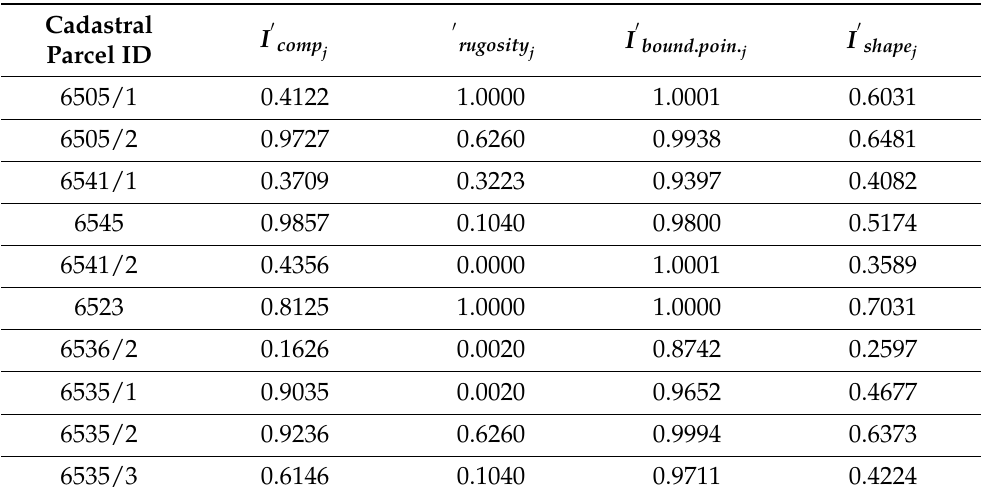
Table 2. Index of compactness, index of rugosity, index of the number of boundary points, and the index of shape.